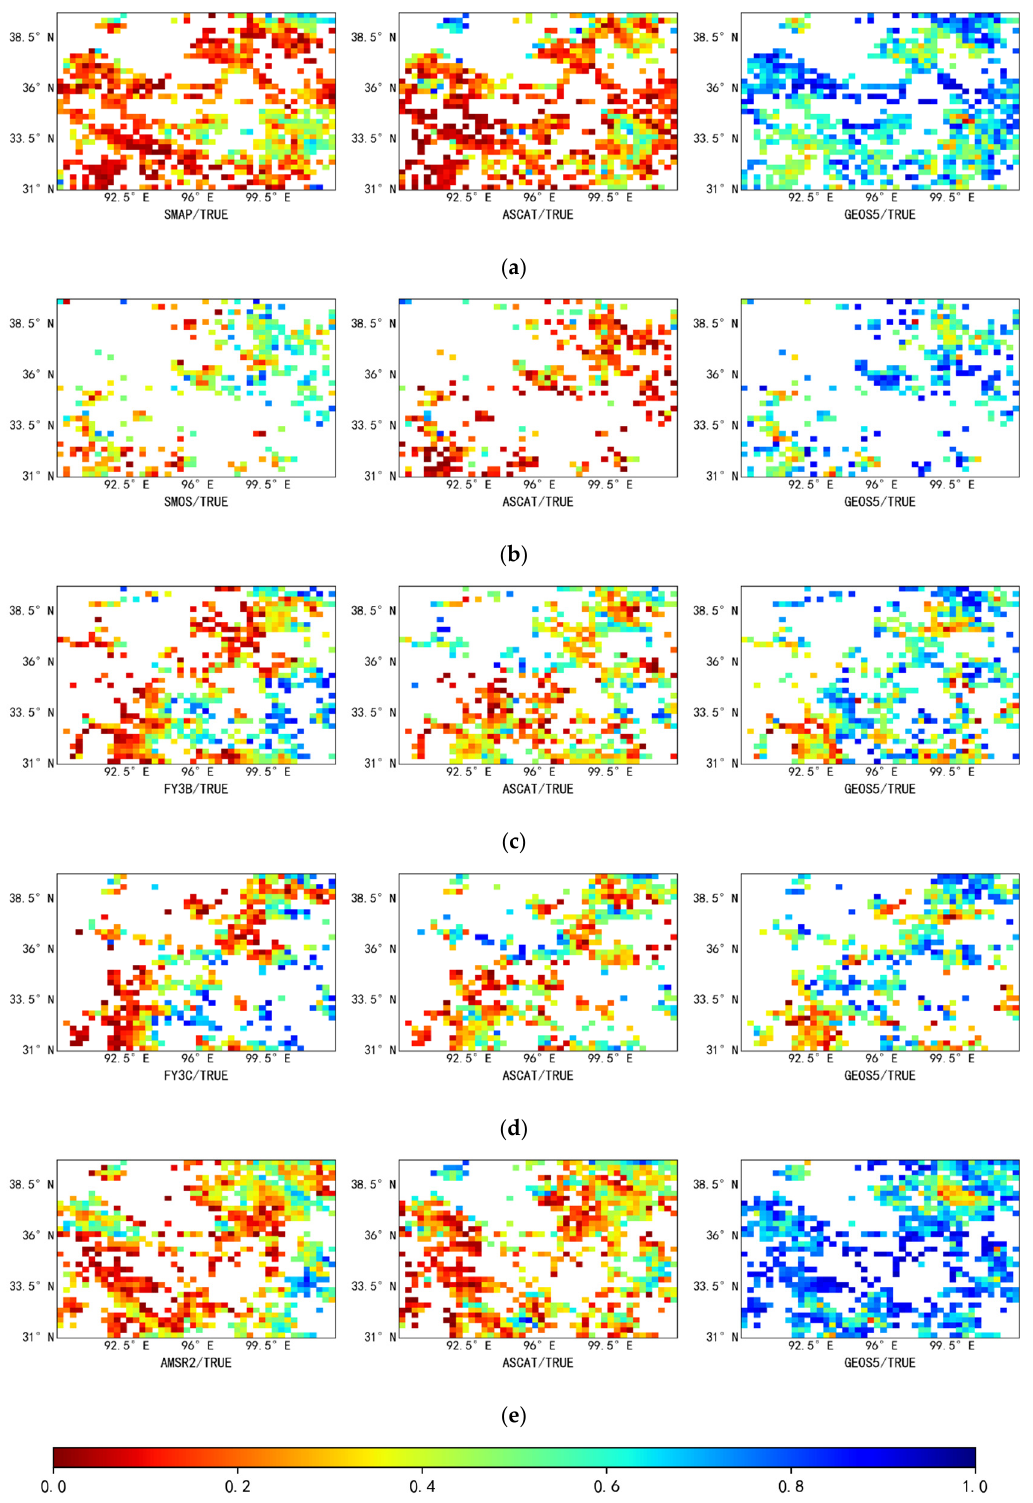
Figure 6. Spatial characteristics of the fractional mean-squared-error (fMSE) in the study area. The five columns of sub-figures show, from top to bottom: ( a ) [SMAP, ASCAT, GEOS5]; ( b ) [SMOS, ASCAT, GEOS5]; ( c ) [FY3B, ASCAT, GEOS5]; ( d ) [FY3C, ASCAT, GEOS5]; ( e ) [AMSR2, ASCAT, GEOS5]. The three rows of sub-figures show, from left to right, the fractional mean-squared-error between the passive and true soil moisture, the fractional mean-squared-error between the active and true soil moisture, and the fractional mean-squared-error between the reanalysis and true soil moisture.